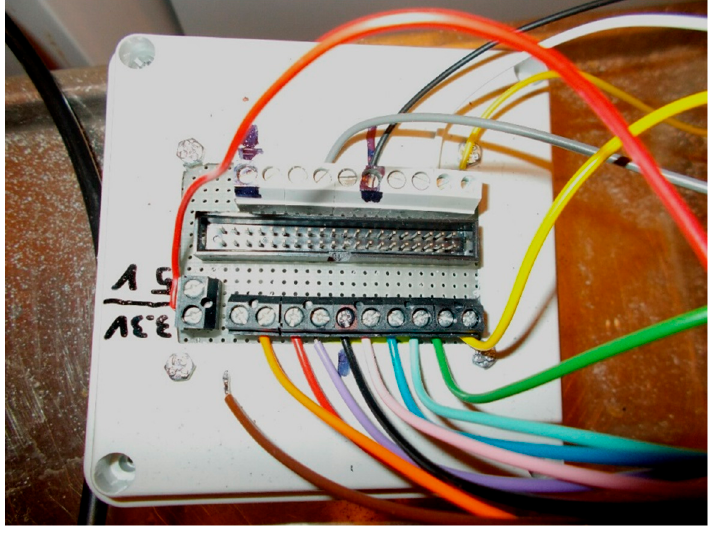
Figure 5. Connector box. Flat cable connector between two line of PCB (polychlorinated biphenyl) screw connectors.